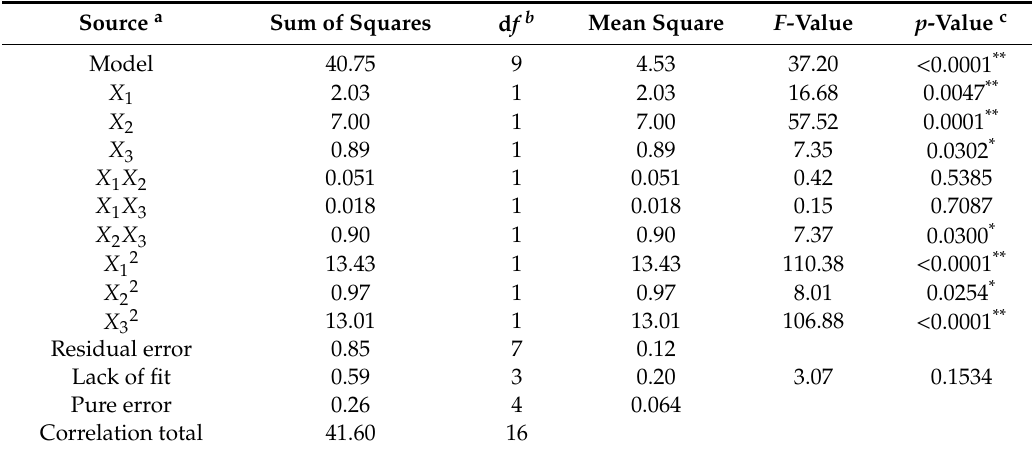
Table 2. Analysis of variance of regression equation and coe ffi